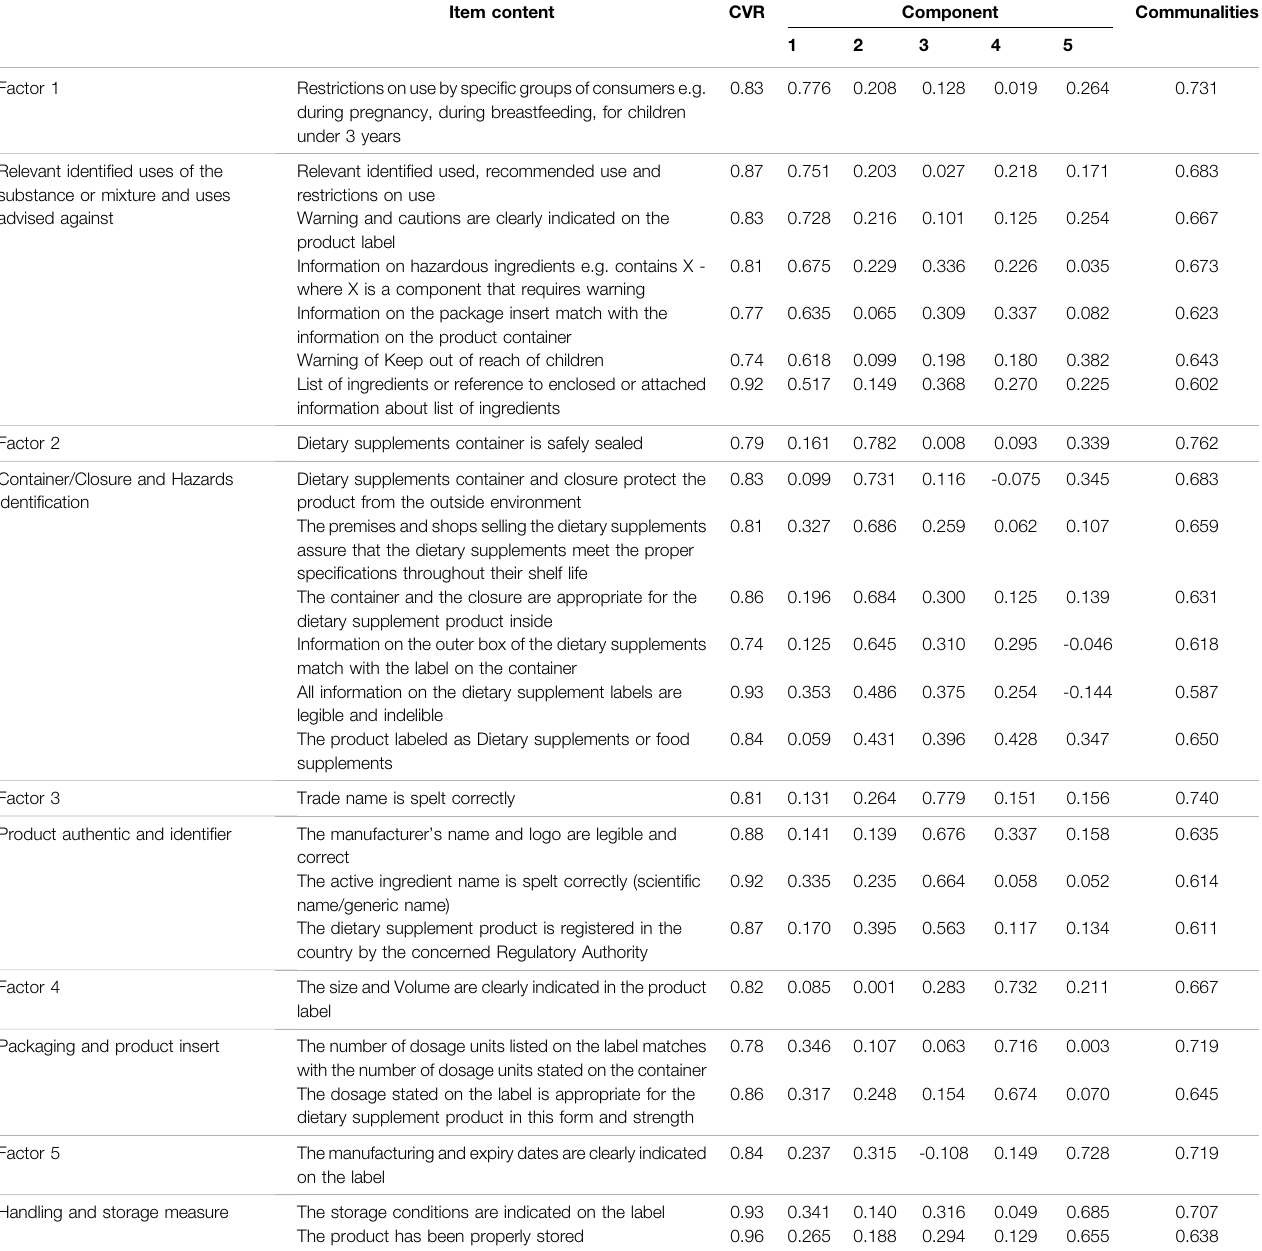
TABLE 2 | Content validity ratio and factor structure emerging from principle factor